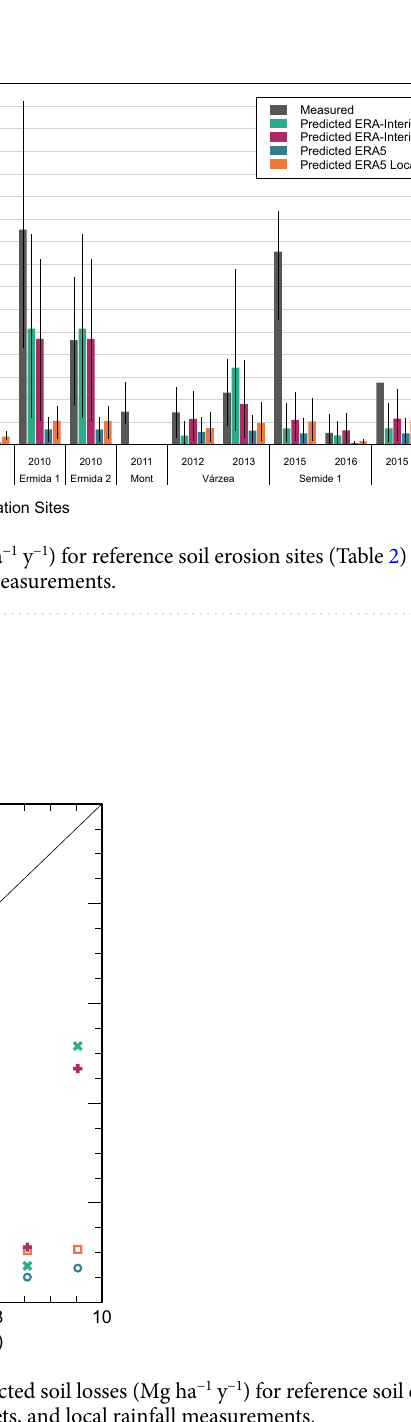
Table 3. MMF performance metrics for the prediction of annual post-fire erosion rates observed at 11 field sites for four different rainfall datasets. NSE Nash–sutcliffe efficiency, PBIAS percent bias, RMSE root mean square error, R 2 coefficient of determination.